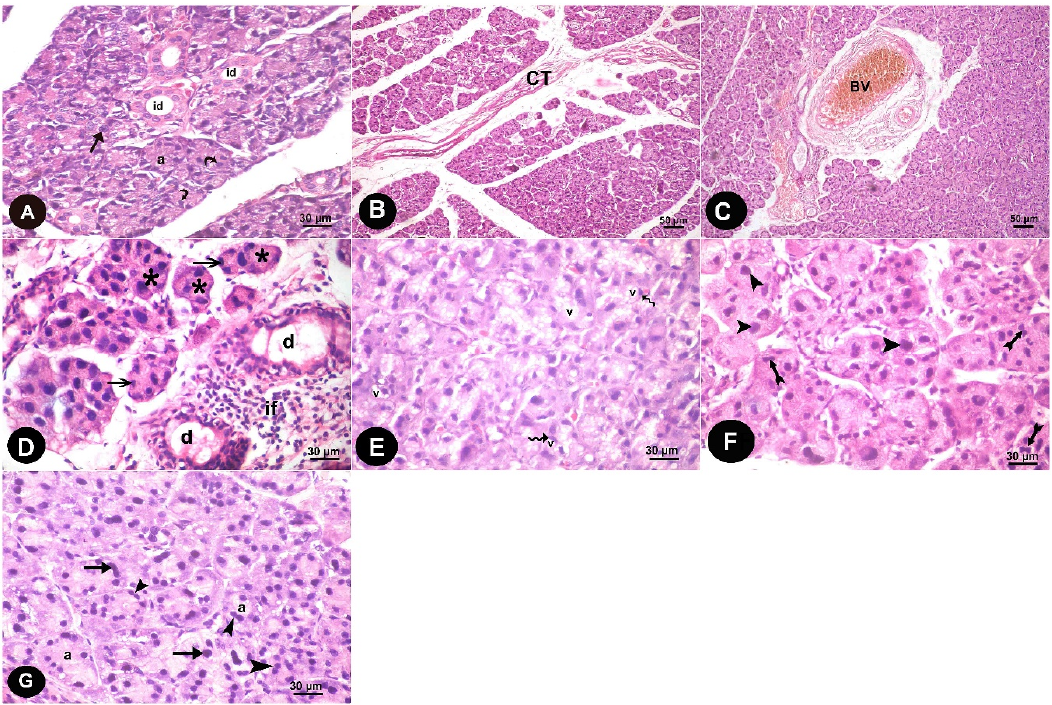
Figure 1. Haematoxylin and Eosin stained sections in parotid tissue of albino rats of the study groups show: Control group: ( A ) The lobular pattern of parotid glandular parenchyma with its serous acini (a) that are lined by pyramidal-shaped cells with rounded basal nuclei (arrow). The interlobular ducts (id) are lined with cubical epithelium (curved arrow). Alternariol group: ( B ) Thick connective tissue septa containing many fibers (CT) are observed between lobes. ( C ) large congested blood vessels (Bv) appeared in the septa. ( D ) disorganized acini with a reduction or disappearance of the central lumen ( * ). Dark pyknotic nuclei appeared in the epithelial lining the acini (arrows). Many dilated interlobular ducts (d) and cellular infiltration (if) are also seen. ( E ) The cytoplasm of the acinar cells showed variable sized vacuoles (v) that displace the nuclei more peripherally (zigzag arrow). ( F ) some acini have dividing nuclei indicating mitosis (arrow head) and others contain large sized nuclei (crossed arrow). AOH+ gallic acid group: ( G ) Most of the acini exhibit well-demarcated edges (a). However, some acini had dark nuclei, while others still appeared to have dividing nuclei indicating mitosis (arrow head). Some cells appeared with few vacuoles (v).